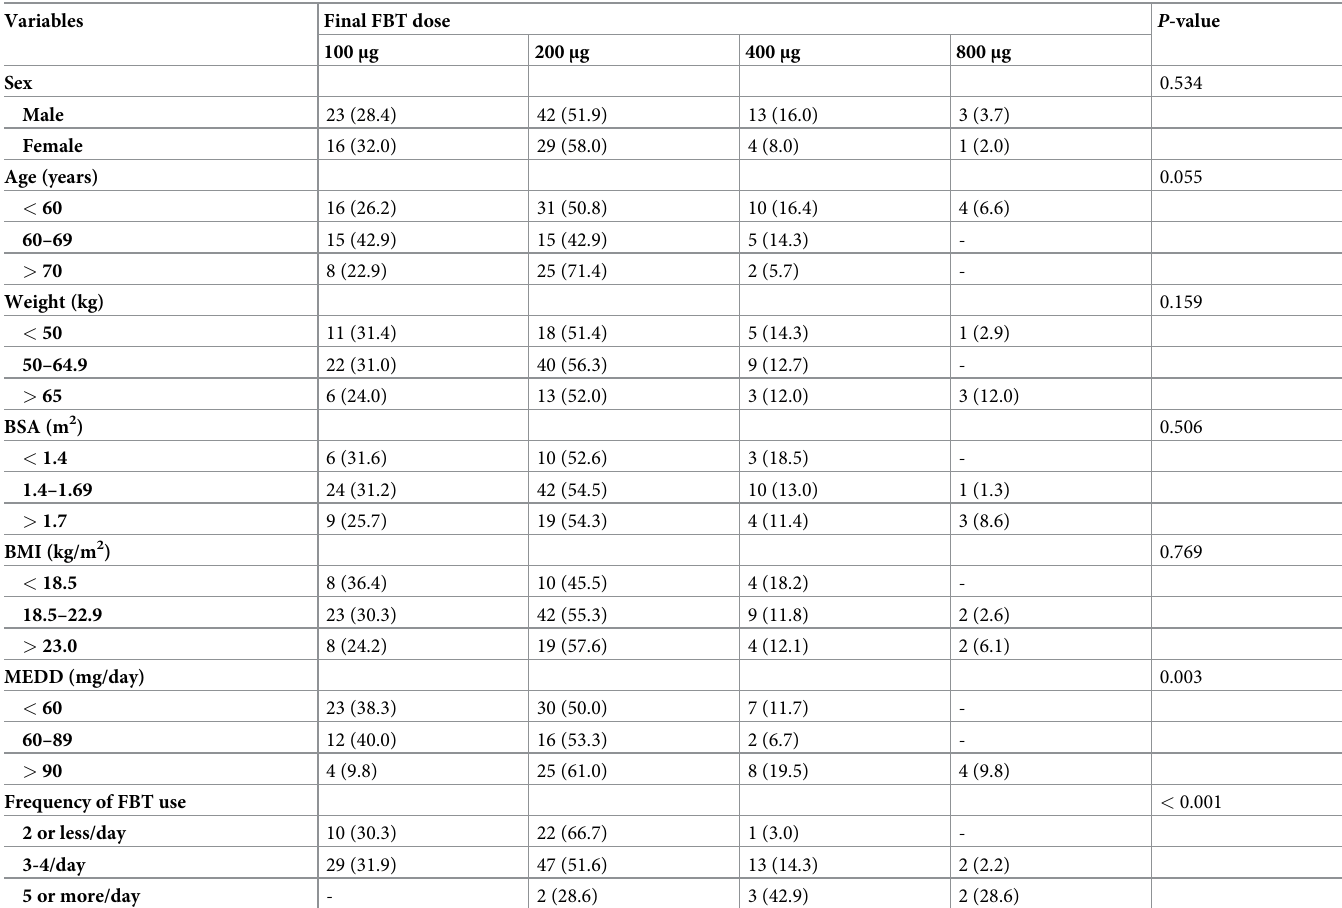
Table 2. Patient distribution between final fentanyl buccal tablet (FBT) dose and clinical